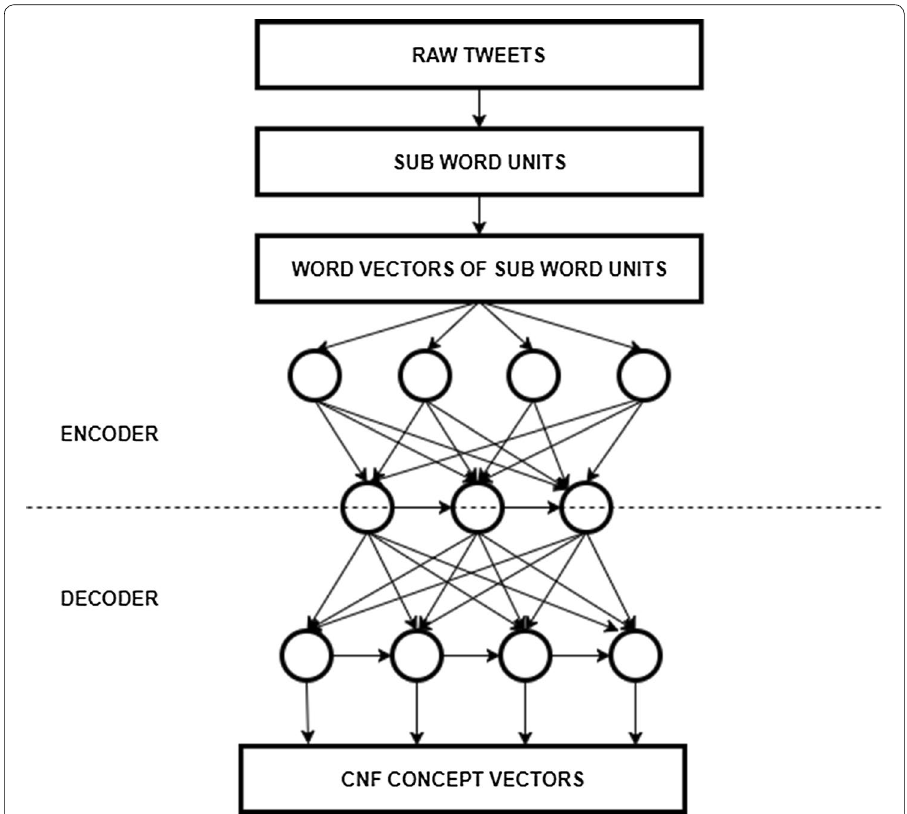
Fig. 11 Propositional neural-linguistic pipeline for feature